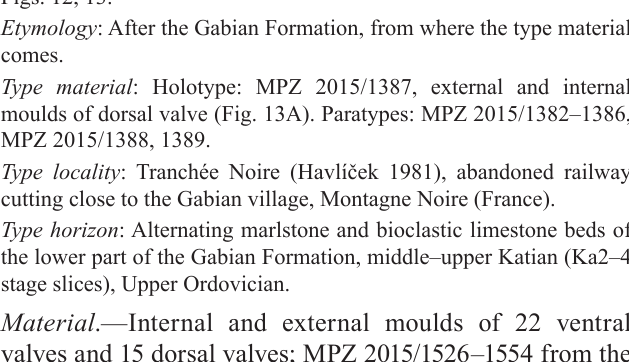
Fig. 10. Rafinesquinine brachiopod Kjaerina ( Villasina ) pyrenaica sp. nov. ( A – H ) from lower–middle Katian (Ka1–2), Upper Ordovician, Cavá Formation, Pyrenees, Spain and Kjaerina ( Villasina ) cf. pyrenaica ( I – K ) from Katian, Upper Ordovician, Bruncu de is Mallorus Member of the Punta Serpeddi Formation, Sardinia, Italy. A . MPZ 2015/1372, holotype, internal mould of ventral valve in upper (A 1 ) and lateroblique (A 2 ) views. B . MPZ 2015/1373, paratype, latex cast of exterior of a ventral valve. C . MPZ 11579, paratype, internal mould of ventral valve. D . MPZ 11580, paratype, internal mould of ventral valve. E . MPZ 11578, paratype, internal mould of ventral valve. F . MPZ 2015/1374, paratype, latex cast of dorsal valve (F 1 ) and